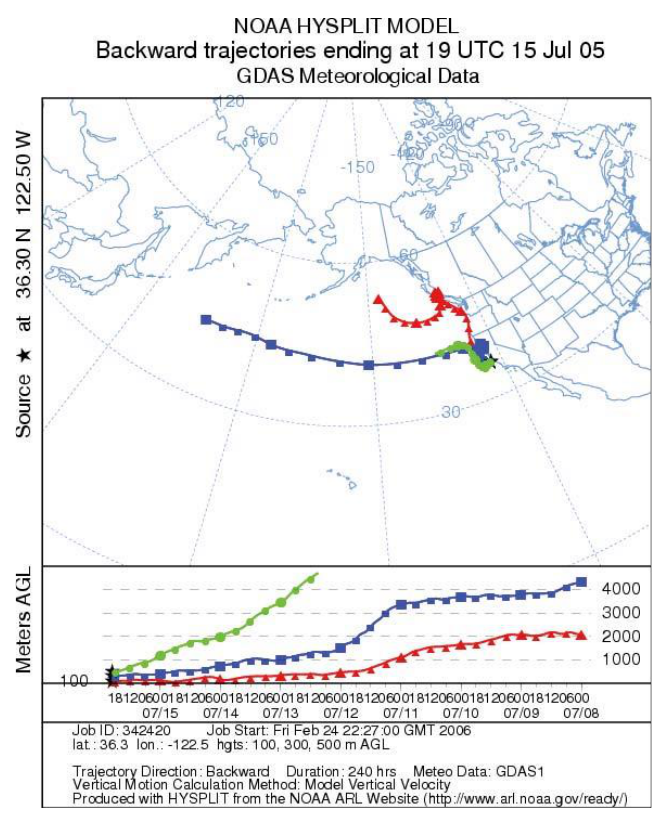
Figure 1. NOAA HYSPLIT (HYbrid Single-Particle Lagrangian Integrated Trajectory) Model Back Trajectories for air masses sampled aboard the Twin Otter on 13 July